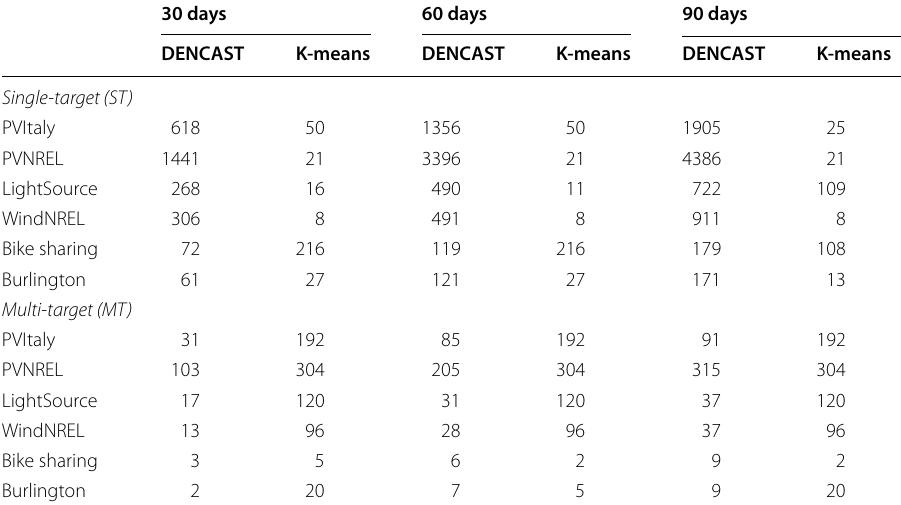
Table 4 Number of clusters extracted by K-means and DENCAST in their best performing configuration for all the datasets and window sizes